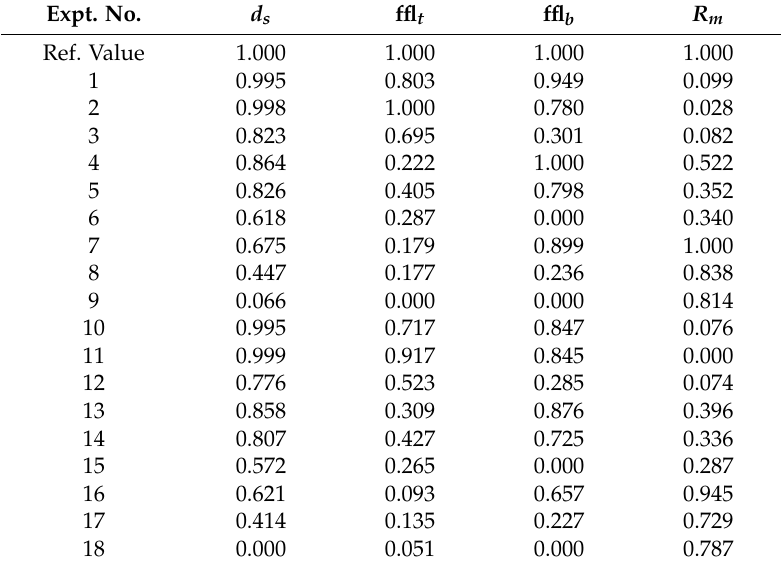
Table 4. Normalized values of each output variable and reference value.